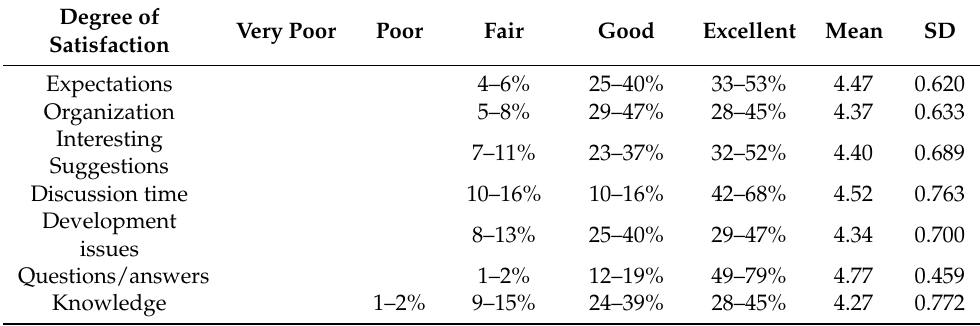
Table 3. Grouped total responses of budding journalists’ “acquired knowledge organization”.